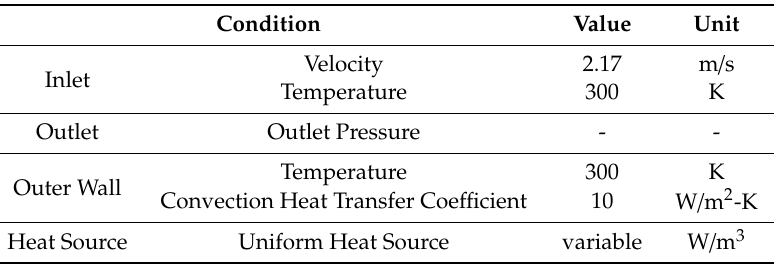
Table 2. Boundary conditions used in the numerical analysis